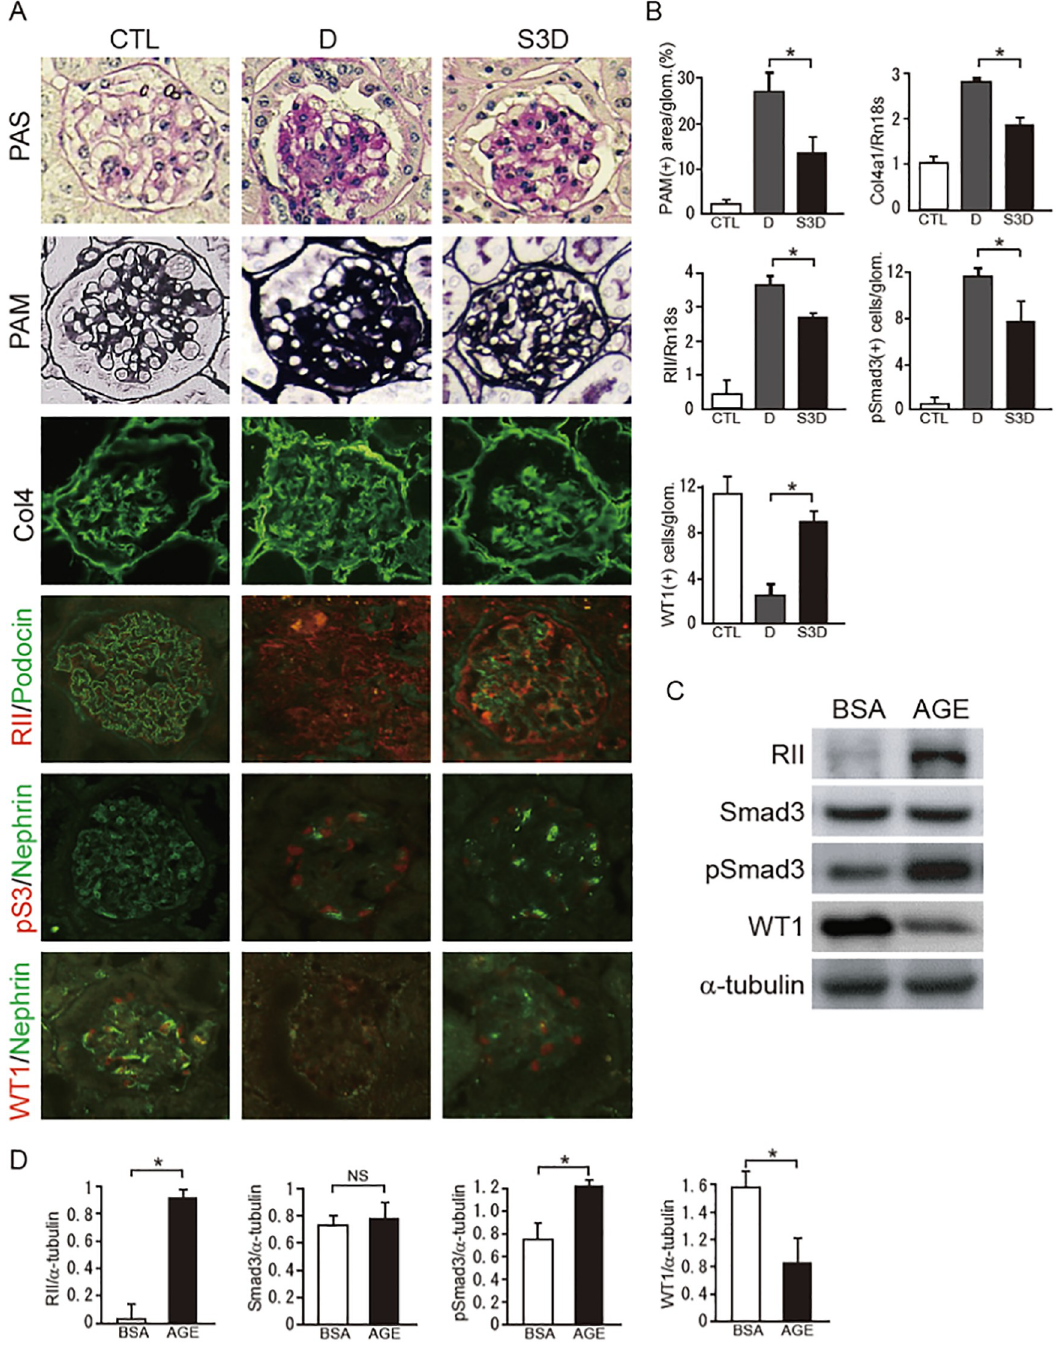
Fig 1. Effect of Smad3 deletion on phenotypic changes on podocytes in diabetic nephropathy. (A) Representative photomicrographs of periodic acid-Schiff methenamine (PAM), periodic acid-Schiff staining (PAS), and immunohistochemical staining are shown (original magnification x400). The left panels are data from normal control (CTL) mice and the middle panels are from db/db mice (D), and the right panels are from Smad3 -knockout diabetic mice (Smad3+/-;db/db mice) (S3D). (B) The mesangial sclerotic fraction was determined in the three types of mice as the percentage of mesangial matrix area per total glomerular surface area. All glomeruli were analyzed in each sample. The levels of Col4 (Col4a1) and RII mRNA in the glomeruli were analyzed by qPCR and normalized to the expression of Rn18s. Regarding pSmad3 and WT1, the number of phosphorylated Smad3- and WT1- positive nuclei were counted, and the mean values (per glomerulus) were calculated. The values are expressed as the mean ± S.E. � P < 0.05. (C) Western blot of protein extracts prepared from cultured podocytes treated with AGE or BSA (5 μ